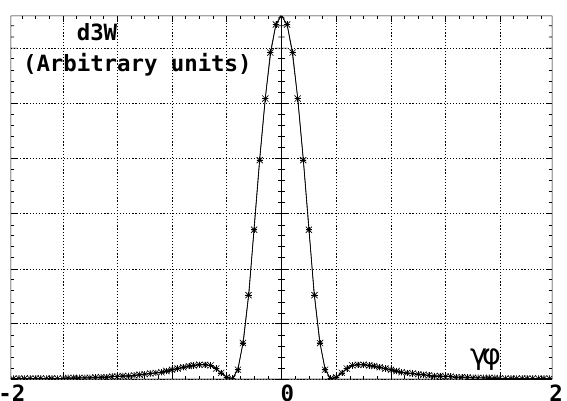
FIG. 13. ≠ 3 W s (cid:4) ≠v≠f≠c vs gf at c (cid:2) 0 , for v (cid:2) 1.13 eV. The solid curve is from numerical simulation, and the crosses are from Eq. (9).